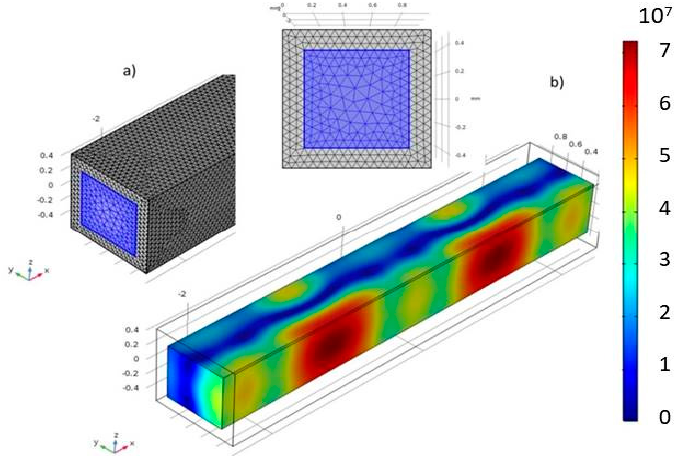
Figure 2. ( a ) 3D FEM modelling of the capillary; ( b ) COMSOL Multiphysics simulation of an acoustic pressure distribution inside the channel at a frequency f = 1.153 MHz Blue color refers to a null pressure amplitude.